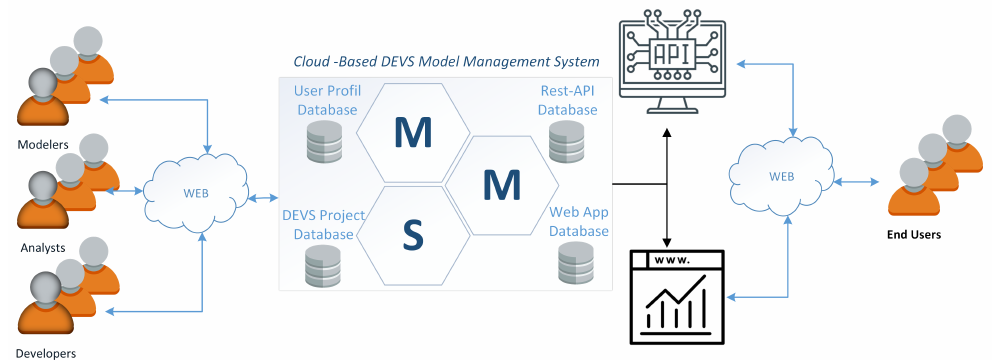
Figure 1. The generic approach proposed for the cloud-based DEVS-MMS is shown in the center of the figure. Modelers, analysts, and developers (on the left), whose profiles are stored in the database, work collaboratively from the database of models and DEVS M&S projects containing, among other things, the results of simulations to specify and implement DEVS simulation models with their web interfaces. DEVS-MMS generates web interfaces (API or web apps), giving end-users (right) the ability to remotely operate DEVS simulation models through the